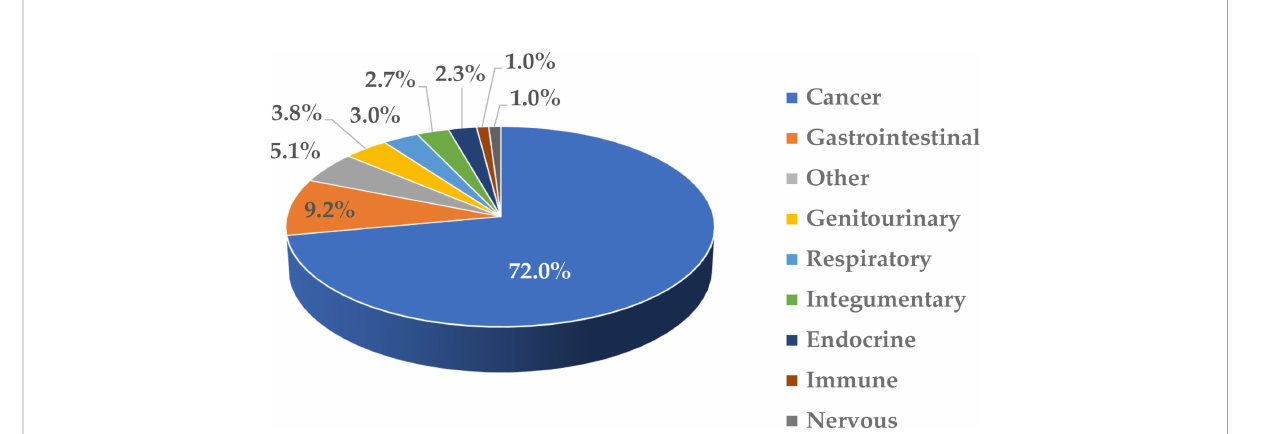
FIGURE 1 Clinical trials involving nanotechnology-based formulations. This fi gure was prepared based on data downloaded from ClinicalTrials.gov (8)